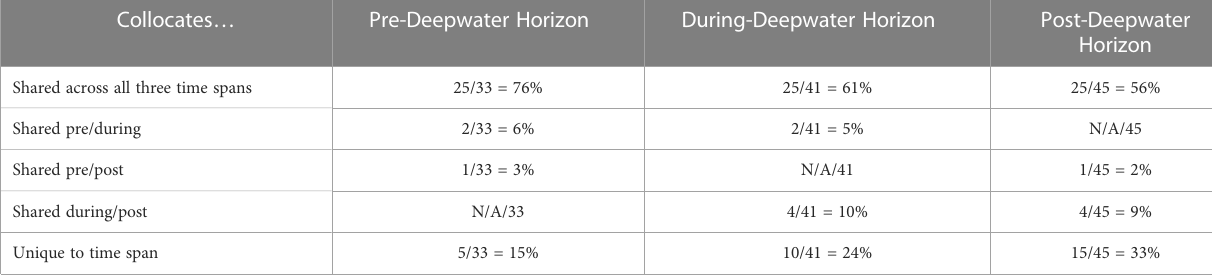
TABLE 3 Percentage of collocates shared across time spans or unique to a time span, by time span. Collocates … Pre-Deepwater Horizon During-Deepwater